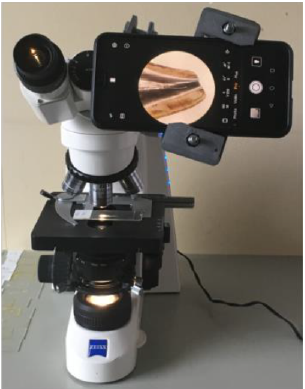
Figure 1. Experimental setup: smartphone, support and light